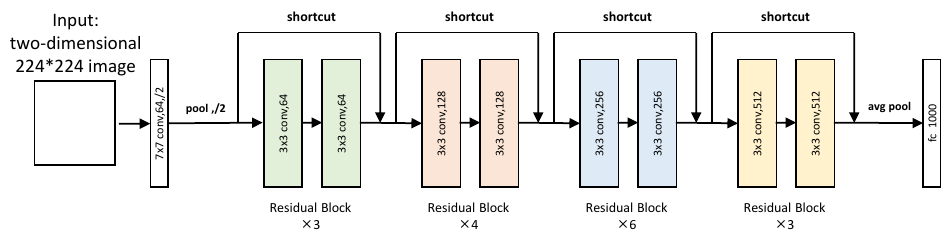
Figure 2. Architecture of ResNet34